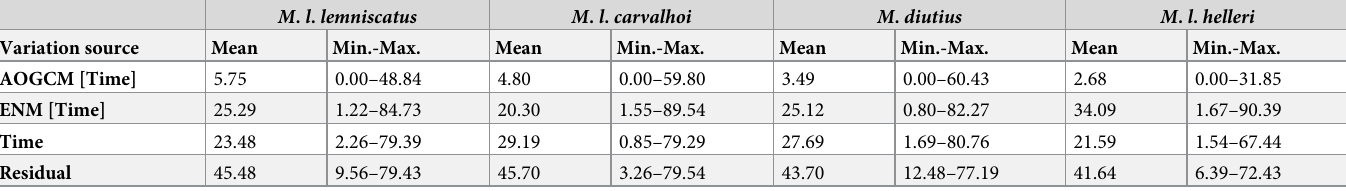
Table 2. Summary of the hierarchical ANOVA output where species environmental suitability was used as response variable, and atmosphere-ocean general circula- tion models (AOGCM) and ecological niche models (ENM) were used as categorical variables nested into two time periods (the present and the end of the century). The values represent the mean, maximum and minimum percentages of the sum of squares through all